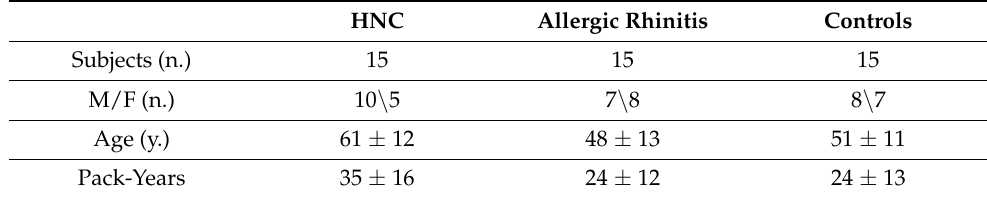
Table 1. Clinical characteristics of the study population. Values are intended as mean ± SD.